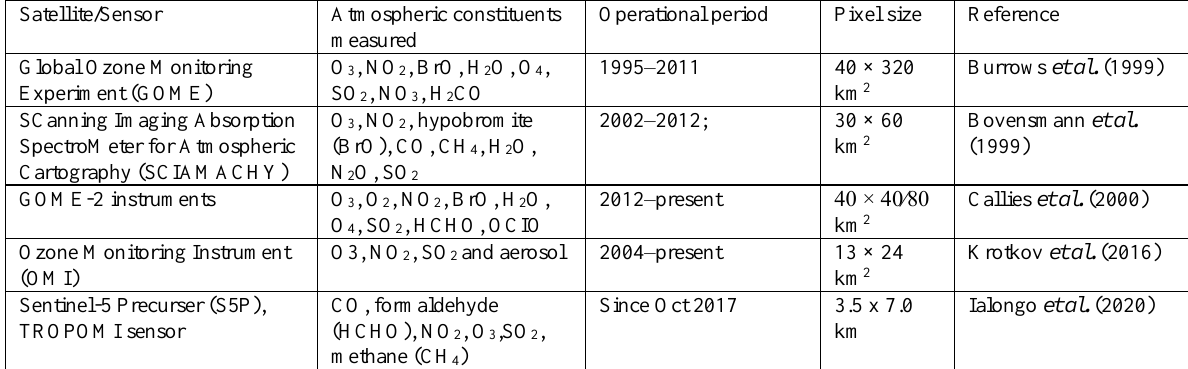
Table 1. Satellites/sensors providing atmospheric gases